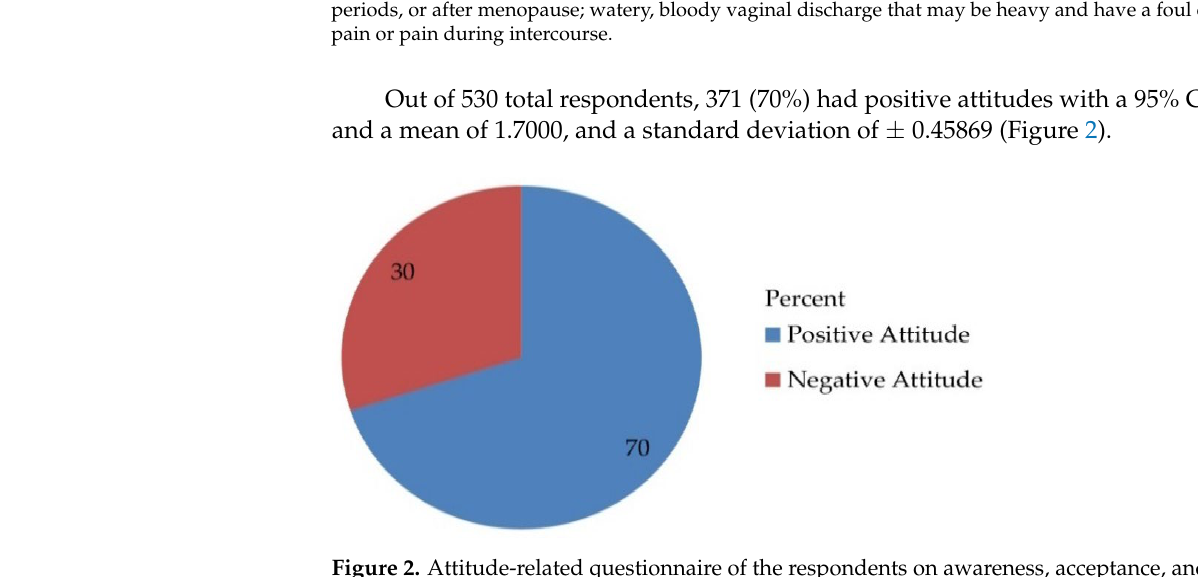
Figure 2. Attitude-related questionnaire of the respondents on awareness, acceptance, and associated factors of human papillomavirus vaccine among parents of daughters in Hadiya zone, southern Ethiopia, 2021 (n = 530).